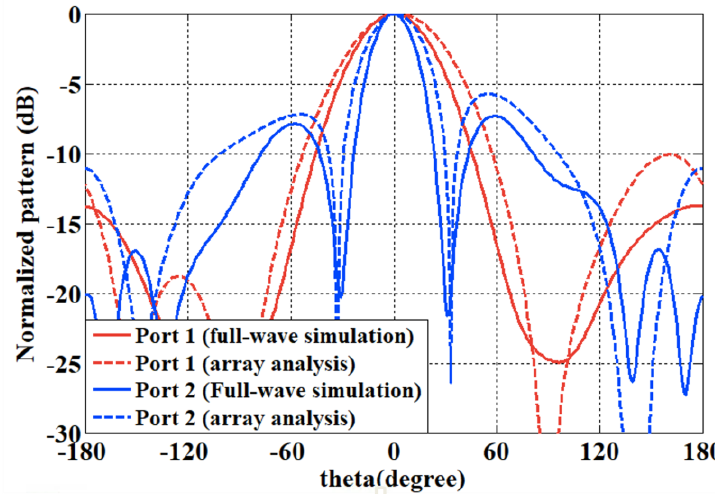
Figure 11. Comparison of normalized radiation patterns using full-wave simulation and array analysis at port 1 and port 2 ( φ = 0 ◦ ).